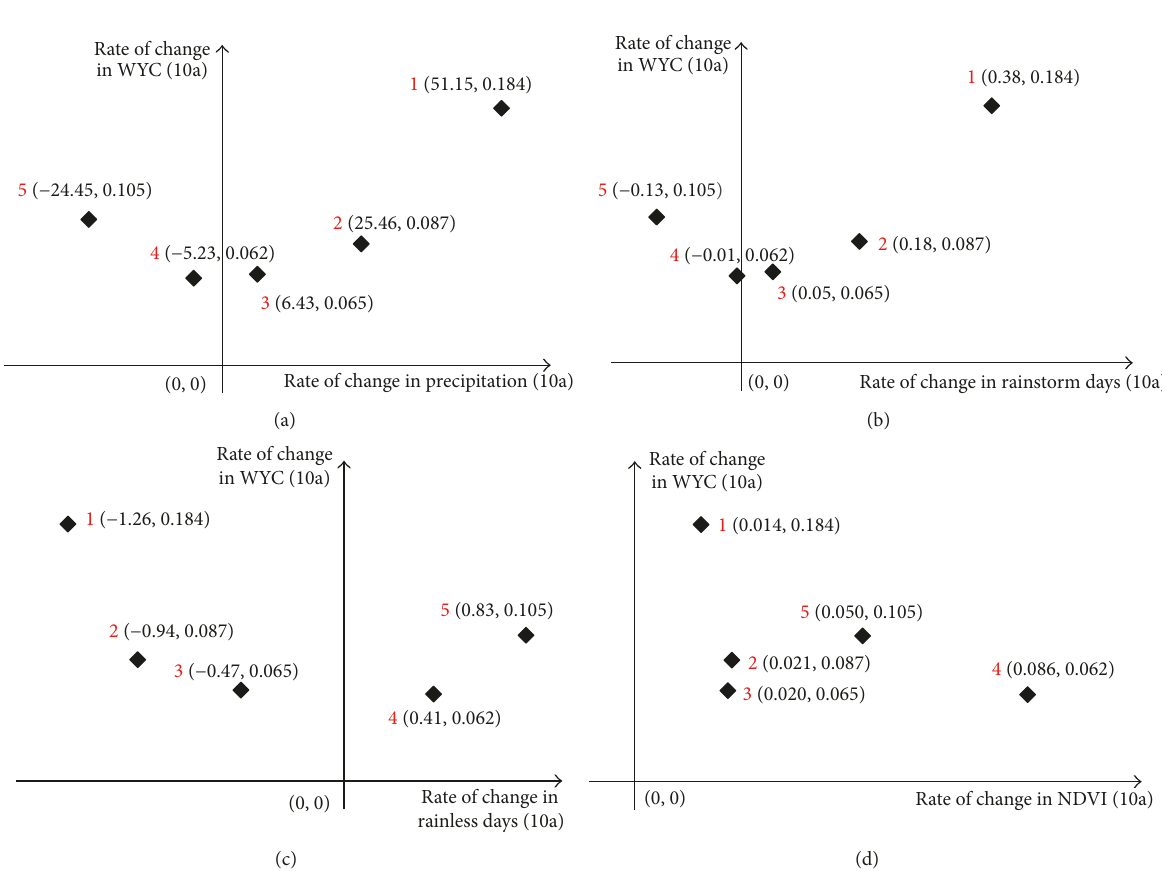
Figure 13: The coupled relationships between WYC and four factors from 1982 to